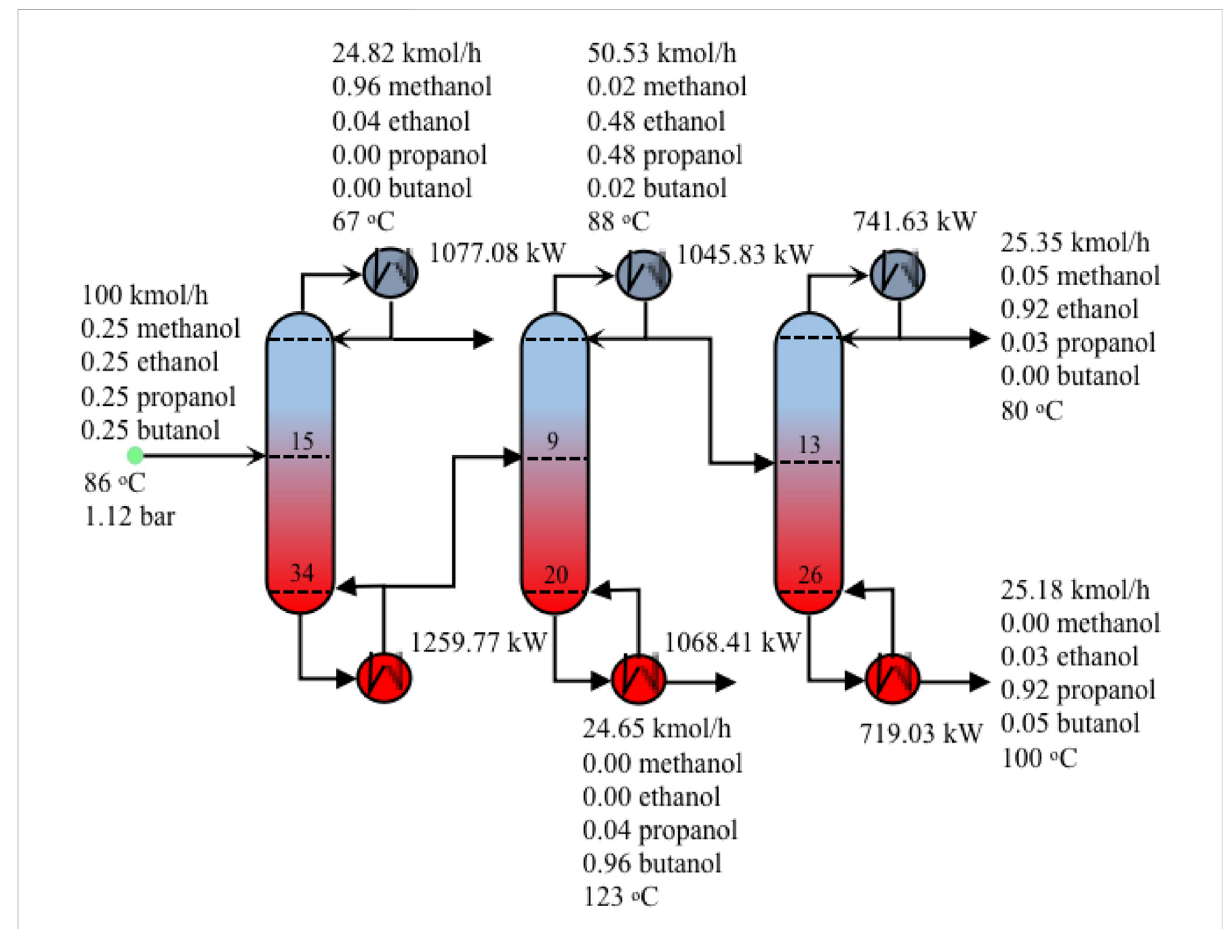
FIGURE 12 Optimal distillation sequence with operating conditions for Example 5.